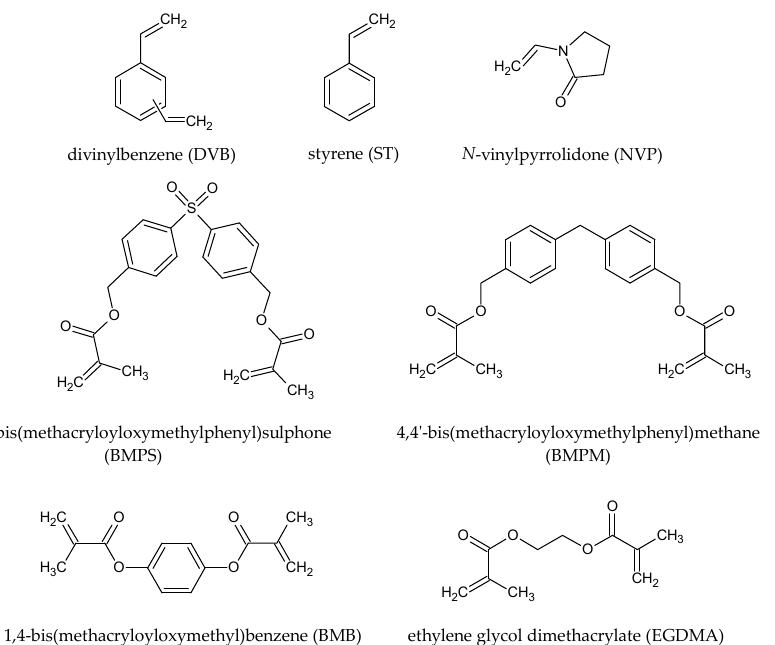
Figure 1. Chemical structures of monomers used for the synthesis of copolymeric microspheres.